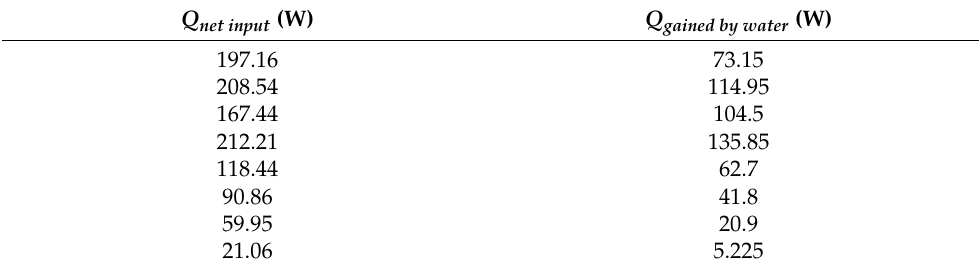
Table 9. Heat gained by water for different heat input.